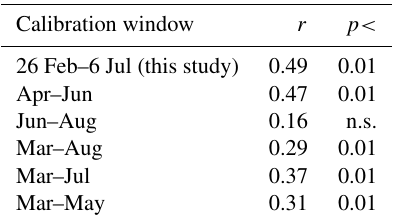
Table A2. Reconstructed dry and wet decades from AD1 to